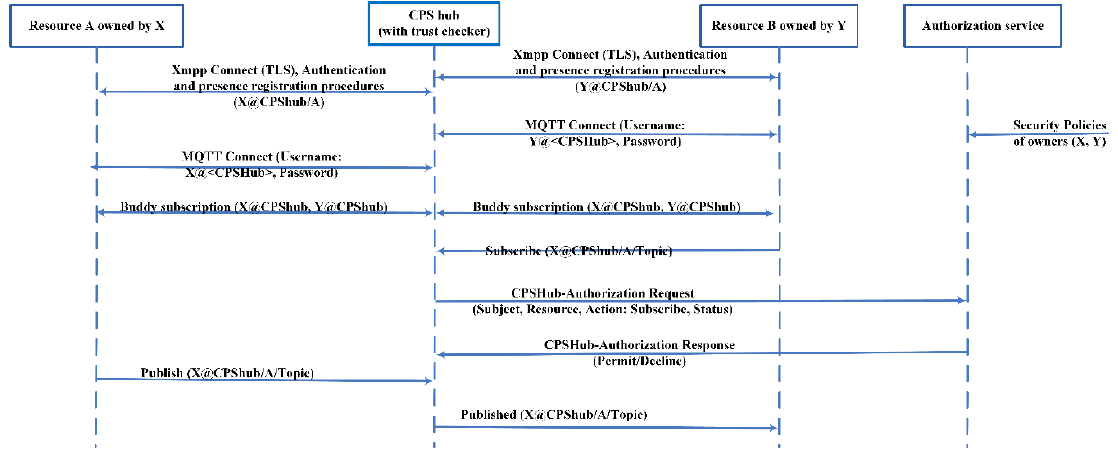
Figure 16. Trust checking procedure of the CPS hub.